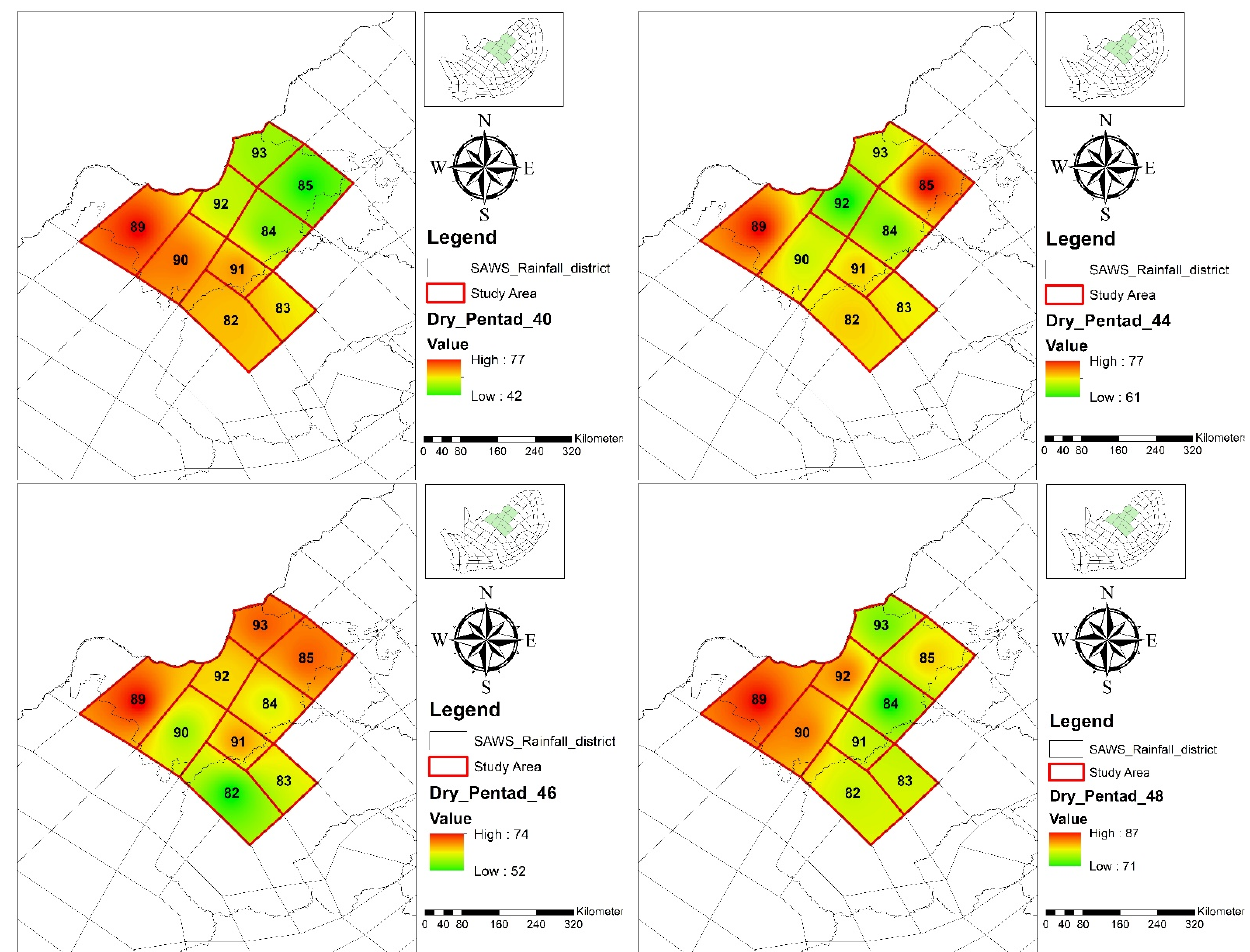
Figure 6. Spatial analysis of initial dry ‐ spell probability ( Pd ) for pentad 40, 44, 46 and 48. The wet ‐ pentad probabilities are low, as expected, due to the high dry ‐ spell probabilities, as shown in Figure 7. For pentad 40 (13–17 January), rainfall districts 84 and 85 had the highest initial wet ‐ spell probability (58%) and the lowest probability of 22% for rainfall district 89. For pentad 44 (2–6 February), district 92 had the highest chance of 37%, and districts 85 and 89 had the lowest chance (22%) of initial wet ‐ spell probability. In pentad 46 (12–16 February), the highest chance of a wet ‐ spell was 48% for district 82, and the lowest probability of 25% was for districts 85, 89 and 93. The highest probability of 29% was observed in district 84 and the lowest in district 89 (12%) for pentad 48 (22–26 February). It is worth noting that district 89 had the lowest probabilities of wet ‐ spells for the study period. These results further highlight that this period is dominated by dry ‐ spells.